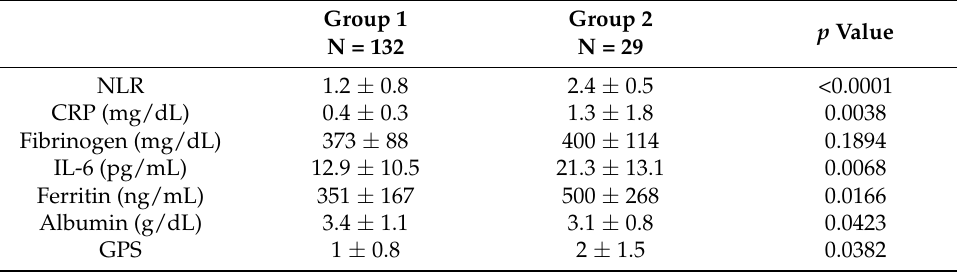
Table 4. Laboratory parameters of the patients after three cycles of chemotherapy.